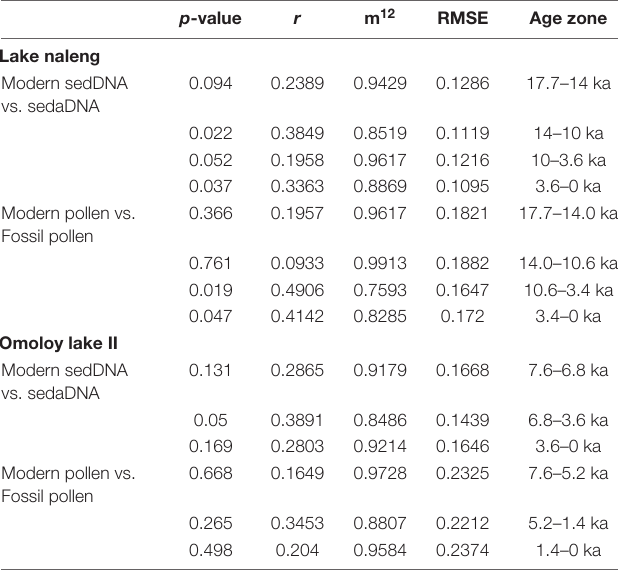
TABLE 2 | Results of the Procrustes and associated PROTEST analysis showing the significant sequences/taxa fit between fossil samples and modern training-set for Lake Naleng and Omoloy lake